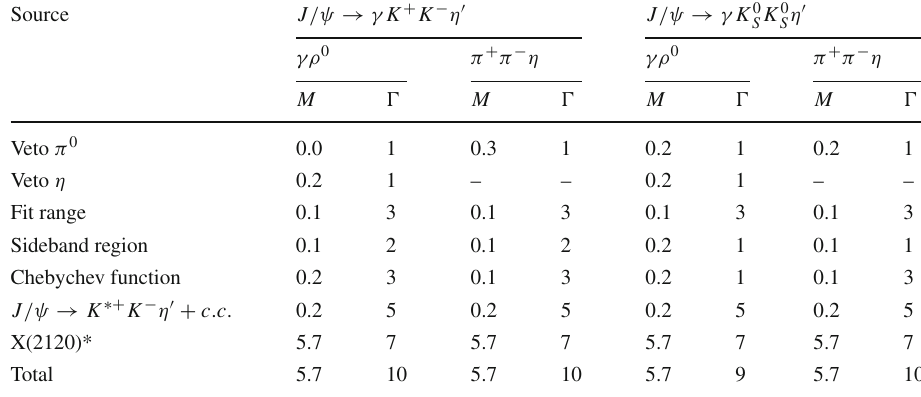
uncertainties of resonance parameters of mass ( M , in MeV / c 2 ) and width ( (cid:6) , in MeV) for X ( 2370 ) . The items with * are common uncertainties of both η (cid:3) decay